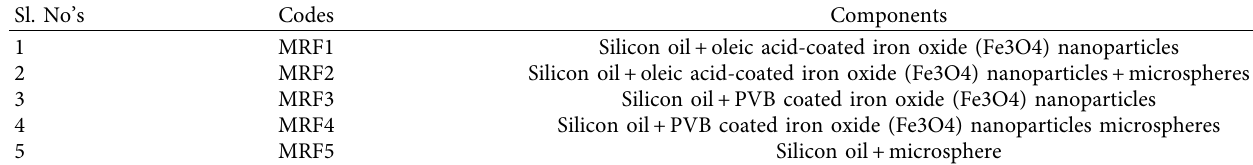
Table 1: Composition and designation of